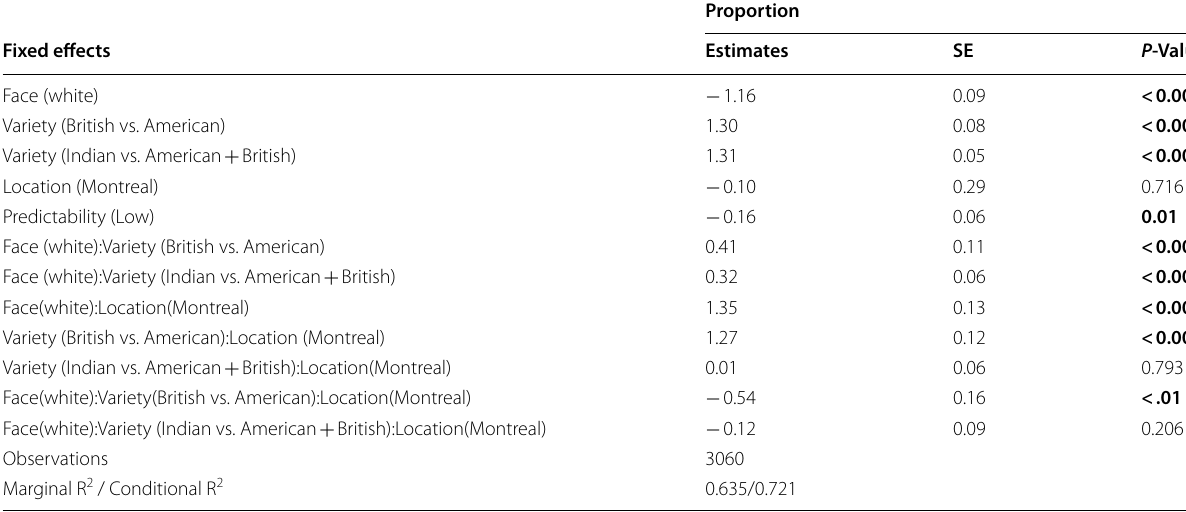
Significant results are in bold